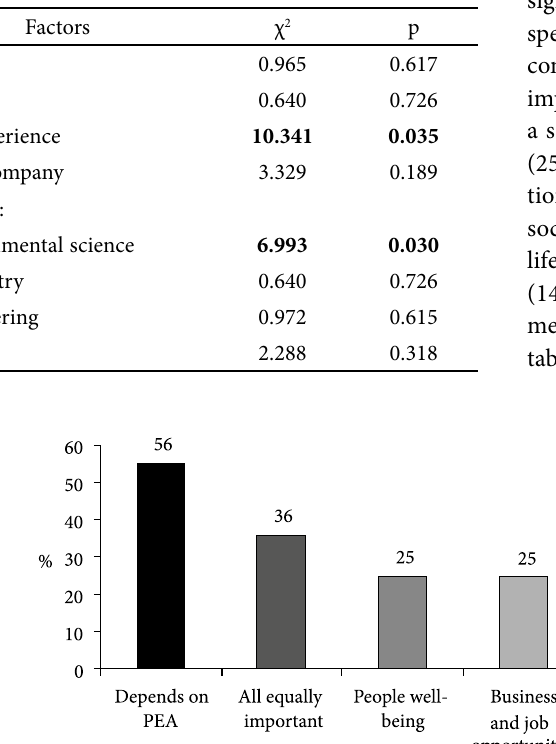
Table 3. Dependence of the EIA specialists’ attitude on different factors (bold values are significant at p < 0.05). Survey results: all respondents